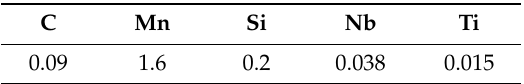
Table 1. Chemical composition of the low carbon steel (wt %).